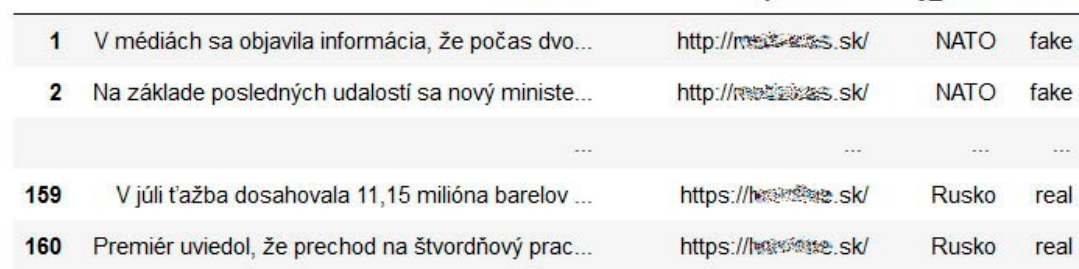
Figure 1. Preview of the created dataset (publisher of the articles is anonymized).